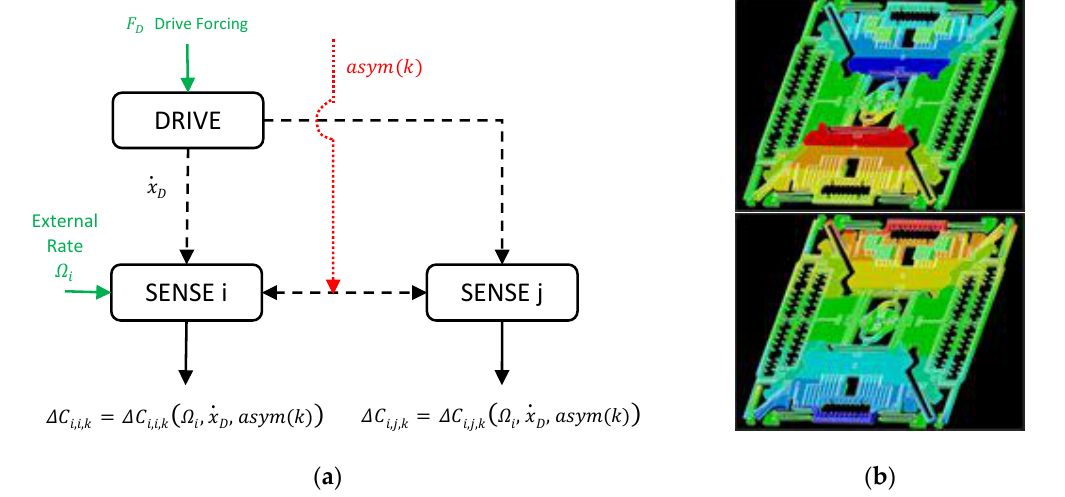
Figure 2. ANSYS simulation model ( a ) General simulation flow ( b ) Contour plot of z- (above) and x-displacement (below) when harmonic simulation is